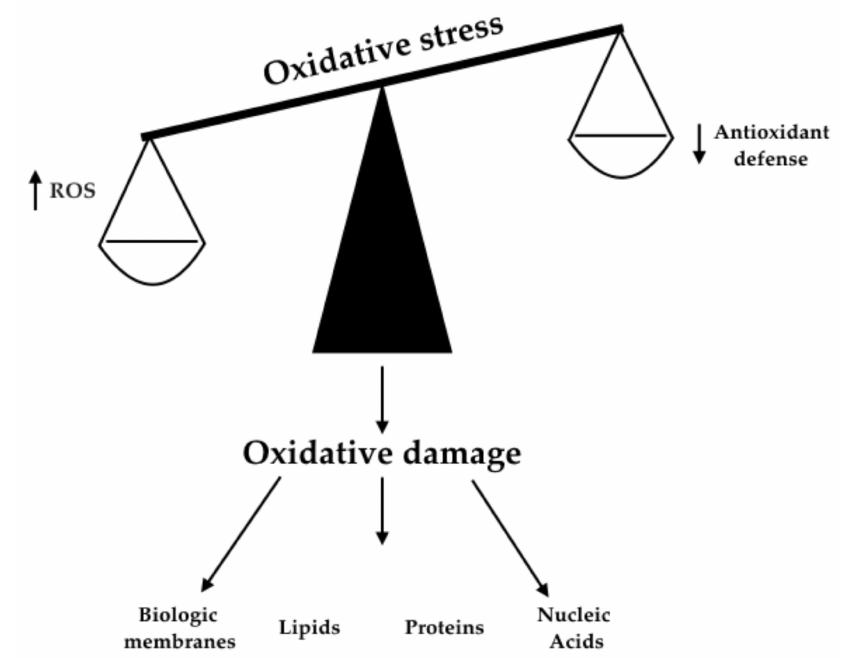
Figure 2. Mechanisms responsible for oxidative stress and cell damage